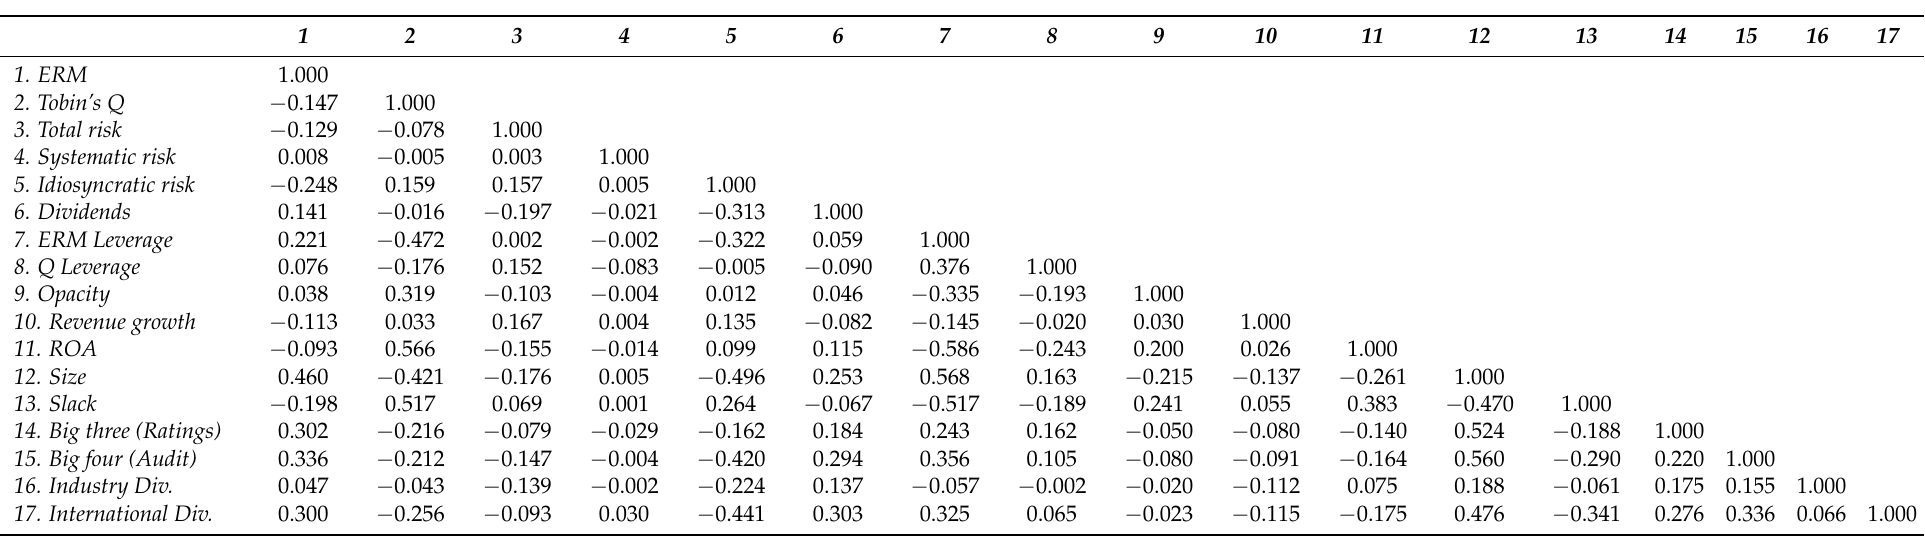
Table 3. Pearson Correlation